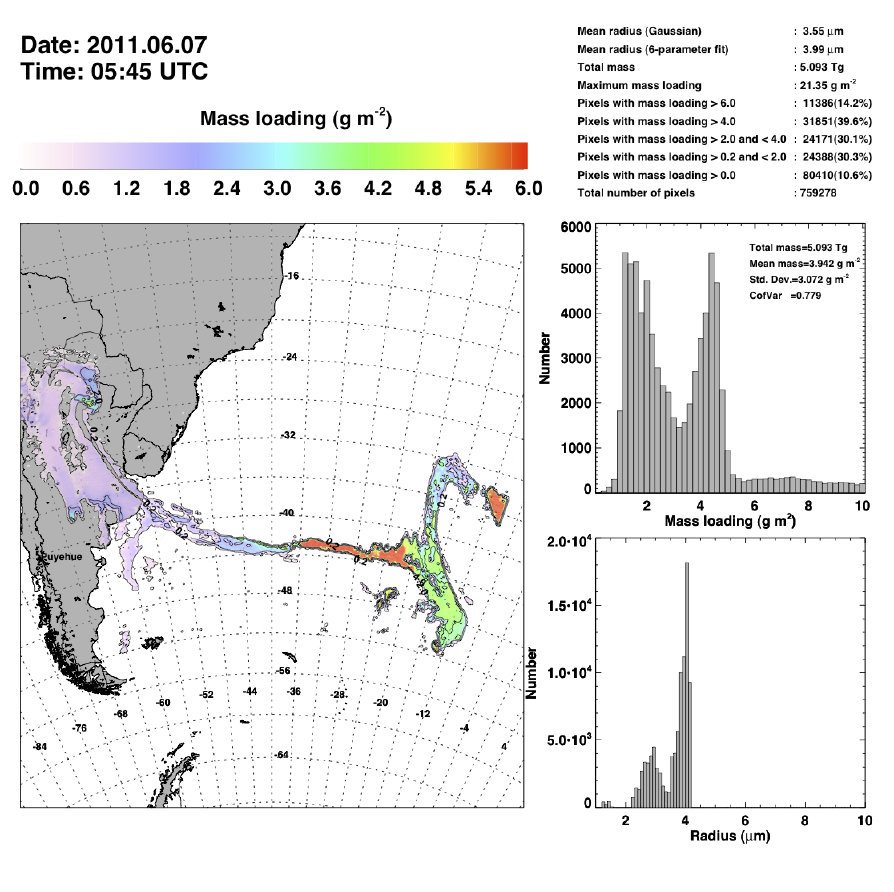
Figure 6. SEVIRI ash mass concentrations (g m − 2 ) for an eruption of Puyehue–Cordón Caulle volcano, southern Chile in June,